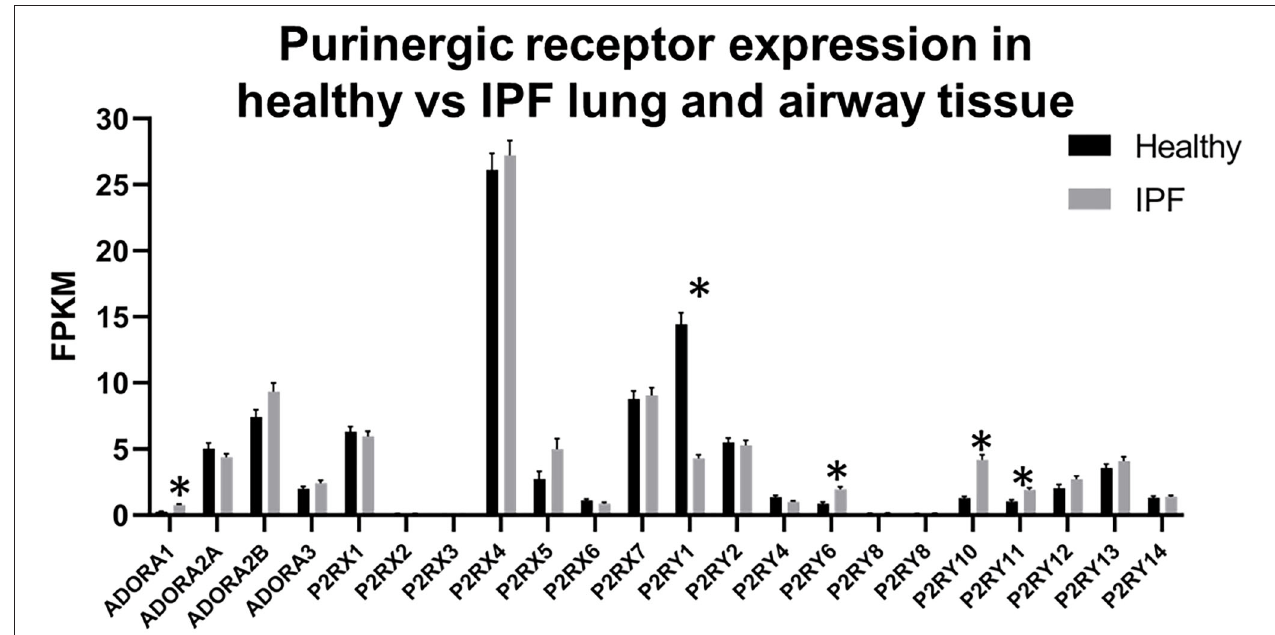
FIGURE 5 | Purinergic receptor expression in healthy vs. idiopathic pulmonary fibrosis (IPF) lung tissue. Data are mean fragments per kilobase per million mapped reads (FPKM) for each purinergic receptor from healthy control (black bars, n = 35) and IPF (gray bars, n = 49) lung tissue [data accessible at NCBI GEO database ( 32), accession GSE124685 (31)]. Multiple t -tests, correcting for multiple comparisons using the Holm-Sidak method, was performed using GraphPad Prism, v.8.4.3 ( * p <